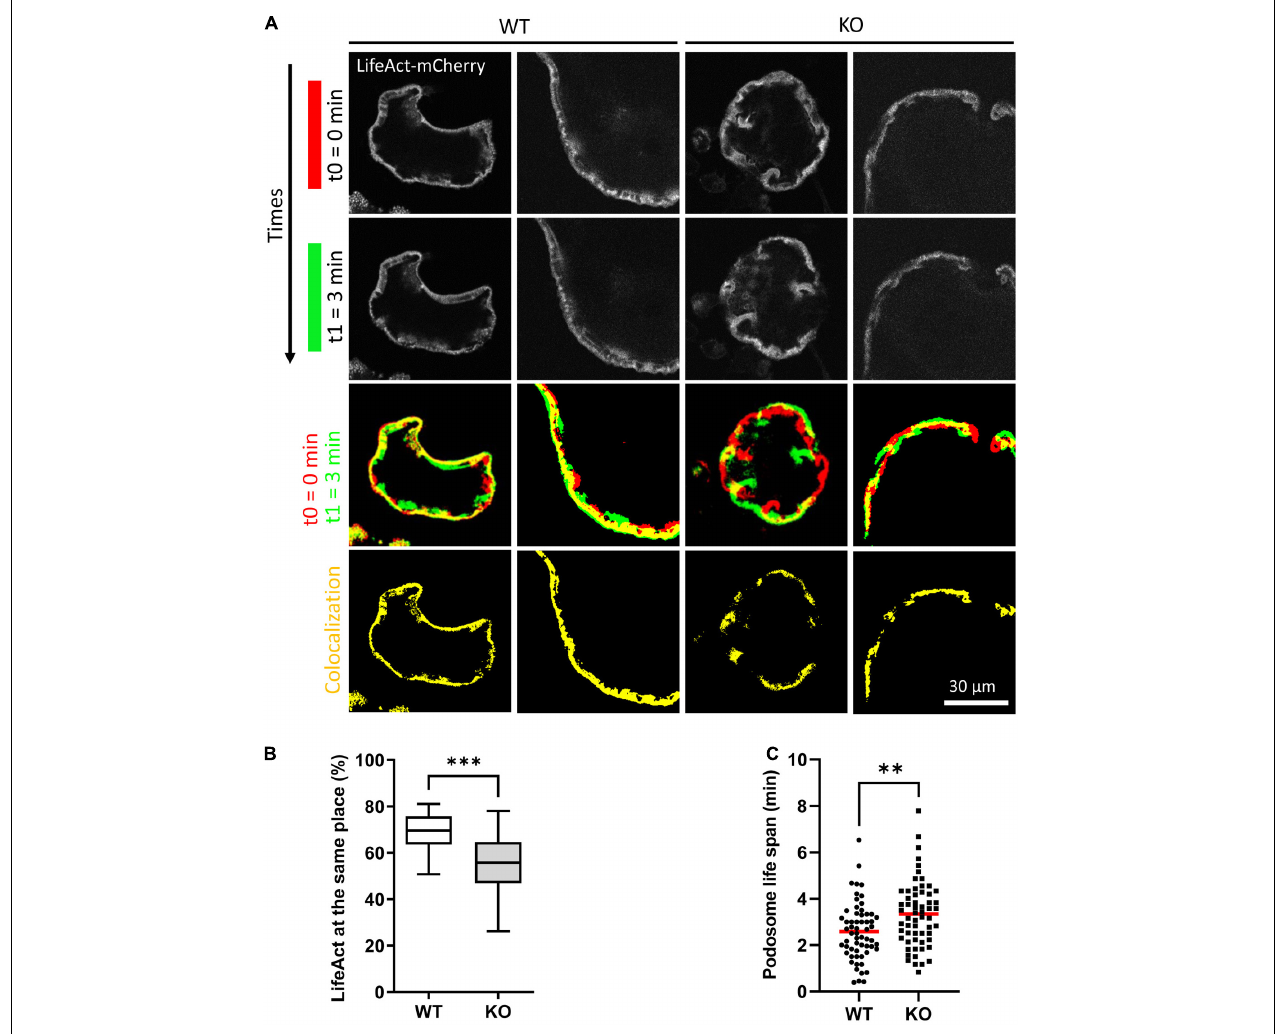
FIGURE 4 | TUBB6 depletion affects podosome belt dynamics. (A) Representative live confocal images of osteoclasts derived from WT or Tubb6 KO osteoclasts expressing LifeAct-mCherry and sitting on glass, showing the localization of LifeAct-mCherry signal at t0 = 0 min (red) and t1 = 3 min (green), with the overlapping areas in yellow. (B) Minimum to maximum boxplot showing the percentage of LifeAct-mCherry signal at t0 that persists at the same position at t3 in WT or Tubb6 KO osteoclasts; in a total of 22 WT and 21 KO osteoclasts from 4 different experiments. Mann–Whitney test: ∗∗∗ p < 0.0002. See also Supplementary Figure 4 and Supplementary Videos 3, 4 . (C) Dot plot showing the life span with mean of individual podosomes in WT or Tubb6 KO osteoclasts. Total of 60 podosomes in six different wild type and KO osteoclasts, from three independent experiments. Student’s t -test: ∗∗ p < 0.002. See also Supplementary Videos 5, 6